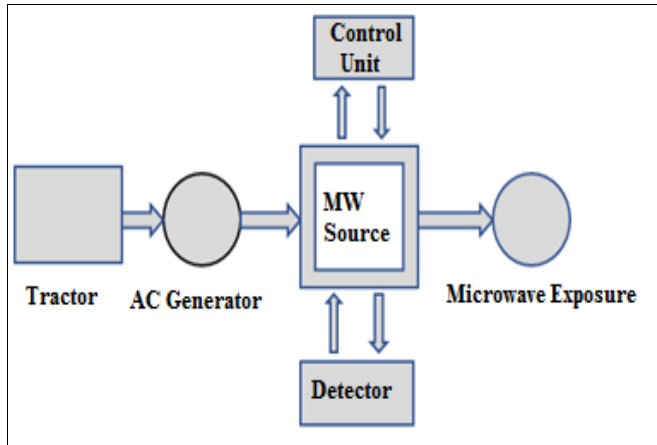
Figure 1: Block diagram of the MW weed